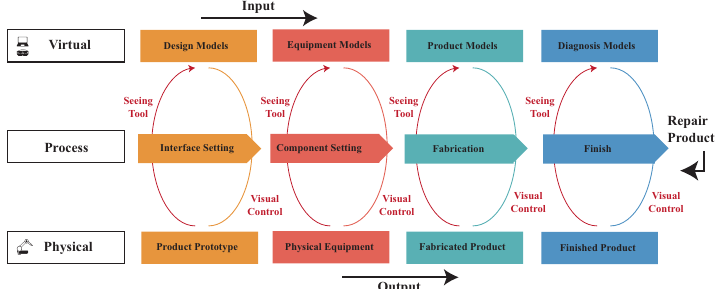
Figure 3. The concept of the visualization system of the DFA (ViDA)